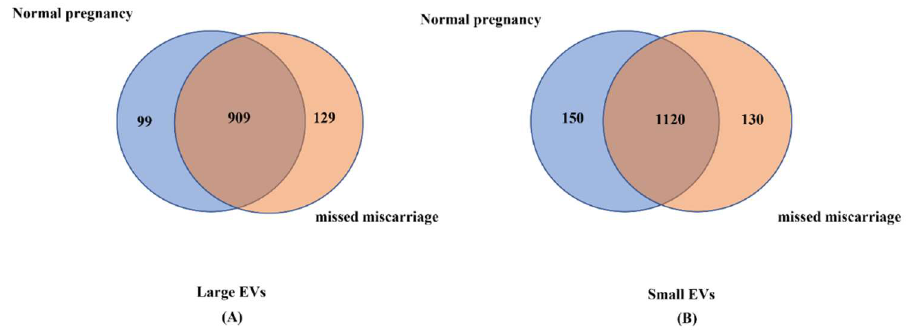
Figure 2. The total number of miRNAs in placental large EVs ( A ) and small EVs ( B ) between EVs derived from healthy or missed miscarriage placentae. derived from healthy or missed miscarriage